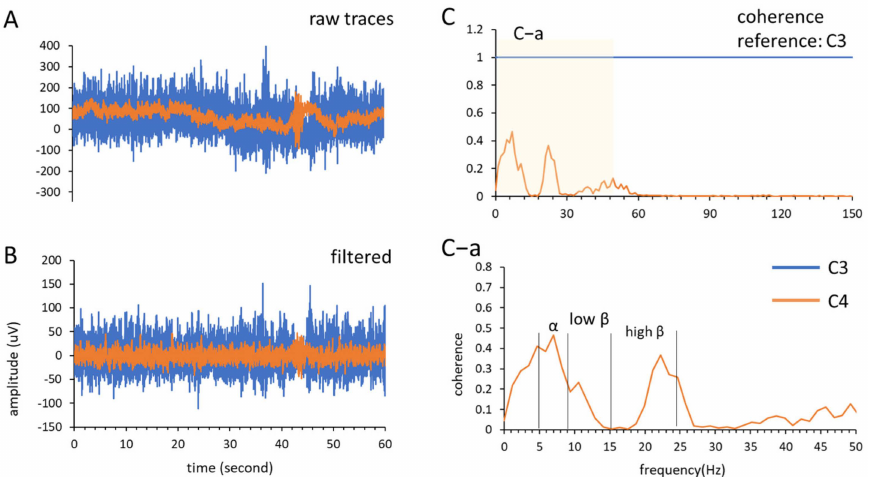
Figure 3. An example of MT × RT condition for coherence sum analysis. ( A ) The raw traces of channel C3 and C4 recoded from stroke patient under MT × RT condition; ( B ) the recorded traces were filtered (pass frequency band: 1–12-Hz); ( C ) coherence analysis using channel C3 as reference, the frequency band range in ( C – a ) was divided into three frequency bands and calculated the coherence sum.